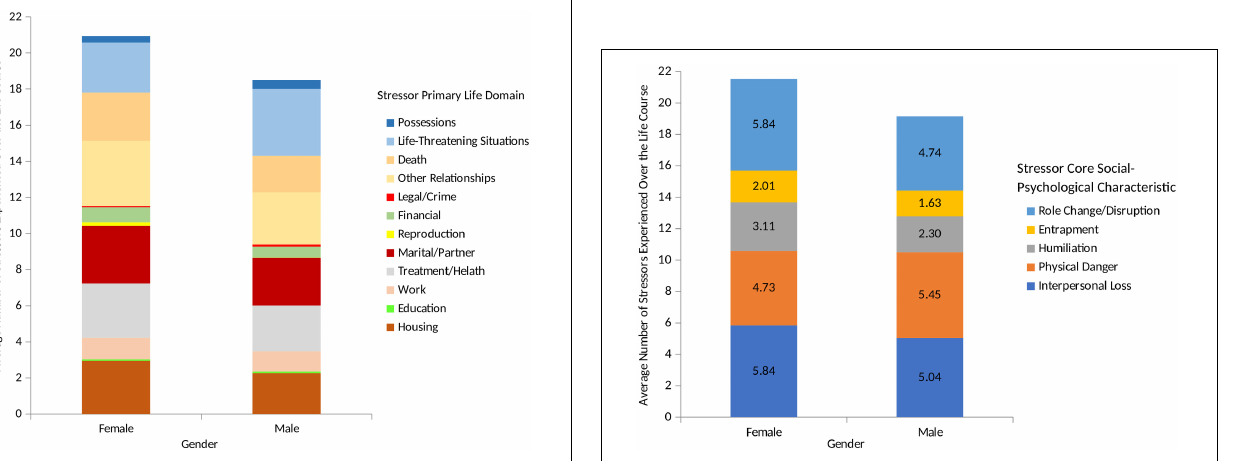
FIGURE 3 | Lifetime stressor exposure by core social-psychological characteristics for males and females. Examining participants’ lifetime stress exposure by gender revealed that with respect to core social-psychological characteristic, women experienced more interpersonal loss, entrapment, humiliation, and role change/disruption stressors than